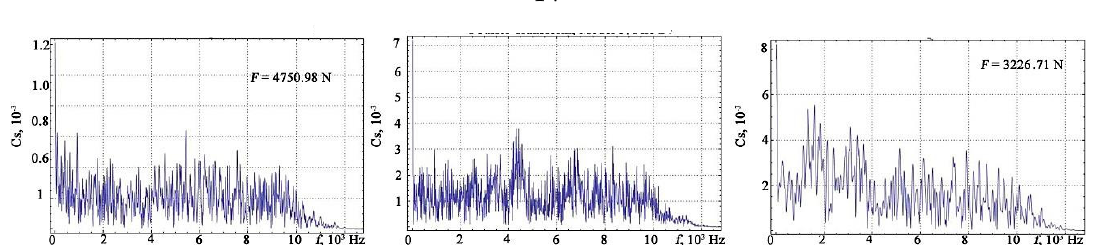
Figure 13. The results of the discrete Fourier transform of the vibration signals under different loads: IV—phase prior to the rupture of the sample.